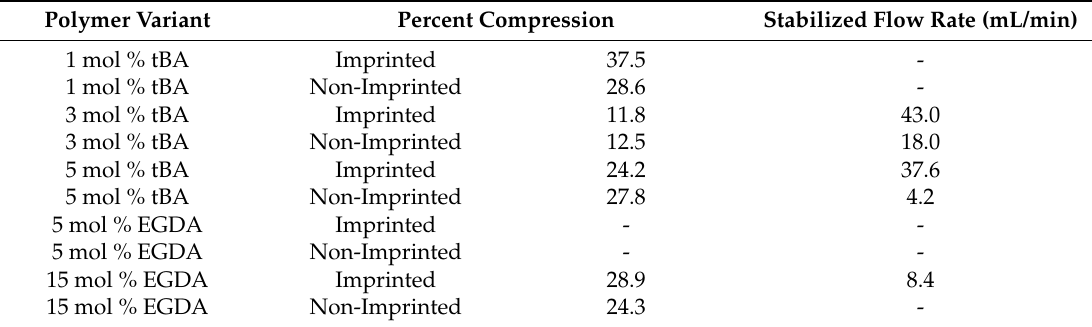
Table 5. Compression and flow rate comparison of all polymer